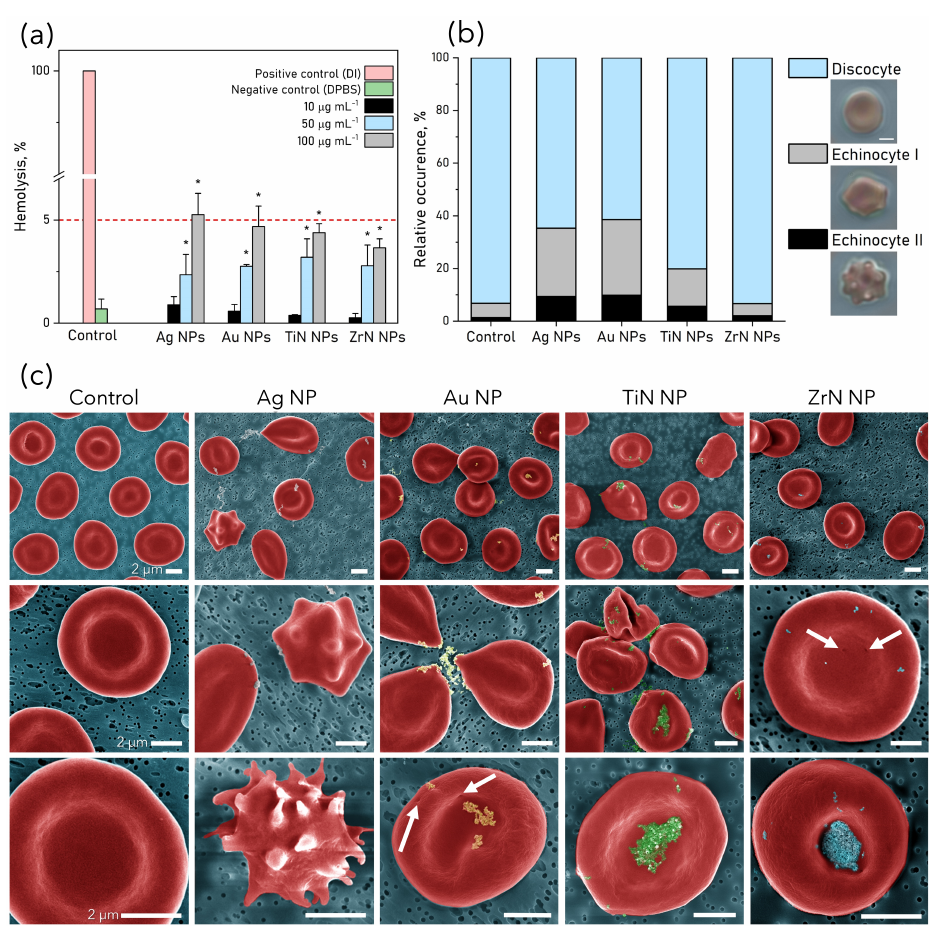
Figure 2. ( a ) In vitro hemolysis test results for RBC (1% hematocrit) exposed to NP for 1 h at concentrations 10, 50 and 100 µ gmL − 1 . The red dashed line indicates the hemolysis threshold value (5%), from which the tested NP are considered hemolytic. RBC in DPBS were used as a negative control, and RBC in DI were used as a positive control. Data are presented as a mean ± SD of three independent experiments and analyzed by one-way ANOVA (post hoc Dunnett’s test). * p < 0.05 are significantly different from the negative control. ( b ) The relative occurrence of RBC fractions by morphology: discocyte, echinocyte I and II (EI and EII), in the samples after 1 h incubation with NP and resuspension in plasma at 50 µ gmL − 1 . Scale bar: 3 µ m. ( c ) Coloured SEM images of RBC incubated for 1 h with plasmonic NP (50 µ g mL − 1 ). Scale bar: 2 µ